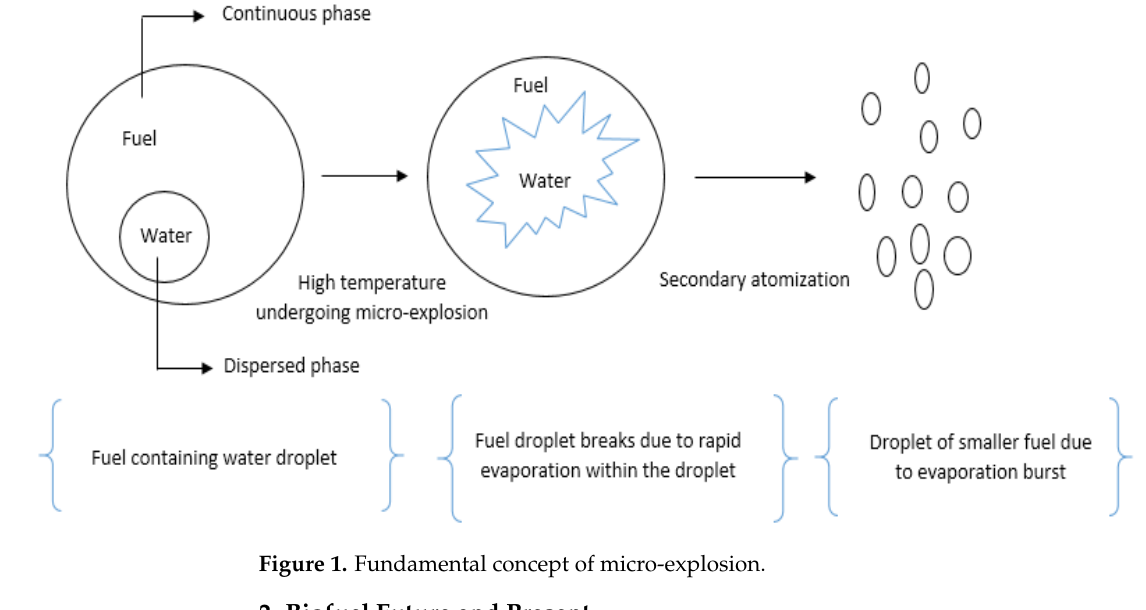
Figure 1. Fundamental concept of micro-explosion.